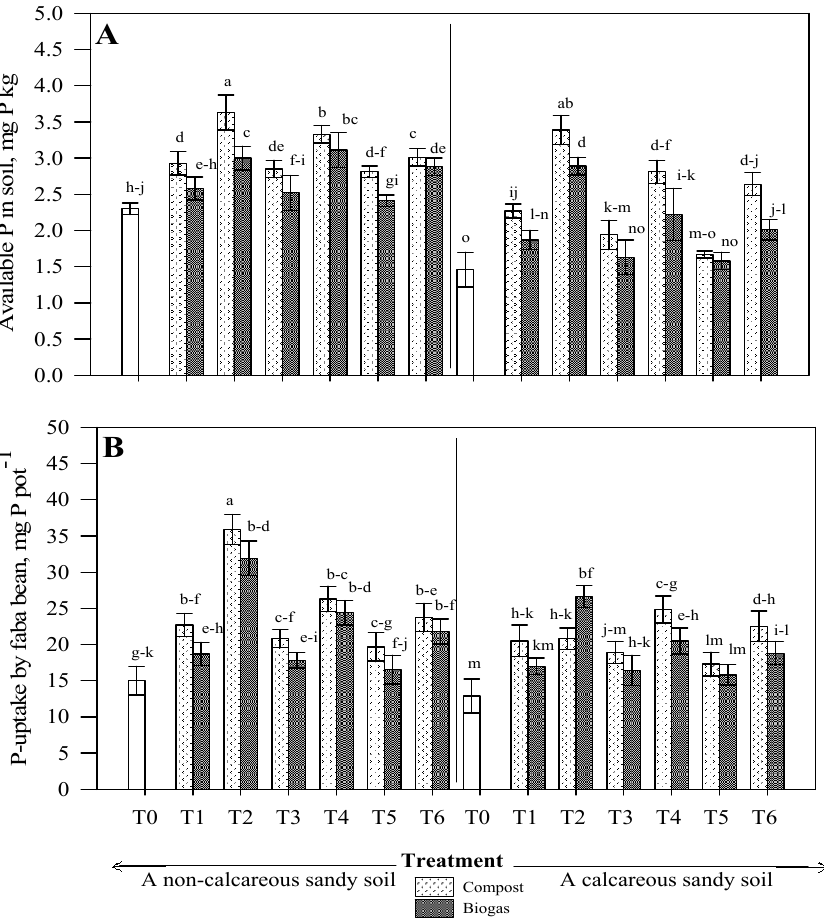
Figure 3. Availability ( A ) and uptake ( B ) of P (mean ± SD) by faba beans as affected by application of organic and mineral N-fertilizer, either solely or in different combinations. Different letters indicate significant variations among treatments.